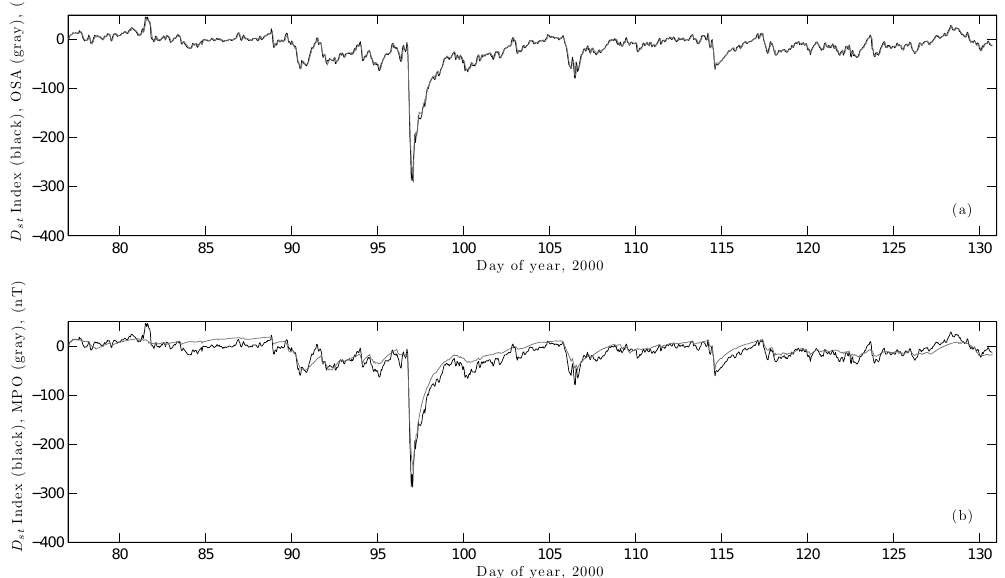
Fig. 3. (a) Measured Dst index in black and OSA Dst in grey. (b) Measured Dst index in black and MPO Dst in grey. Both for the same time period starting from 01:00UT 17 March 2000 until 18:00UT 9 May